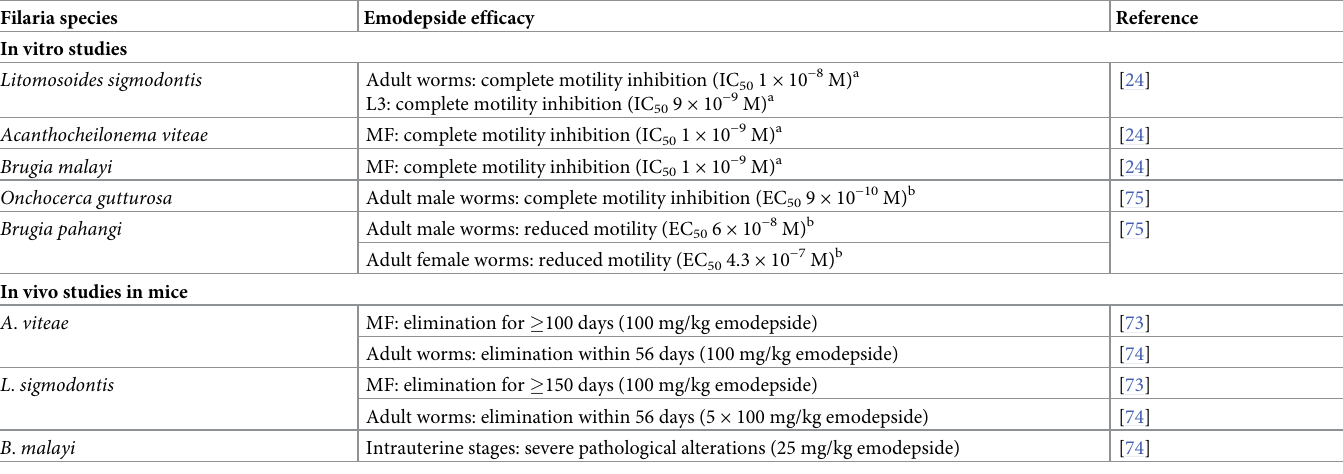
Table 1. Efficacy studies for emodepside against